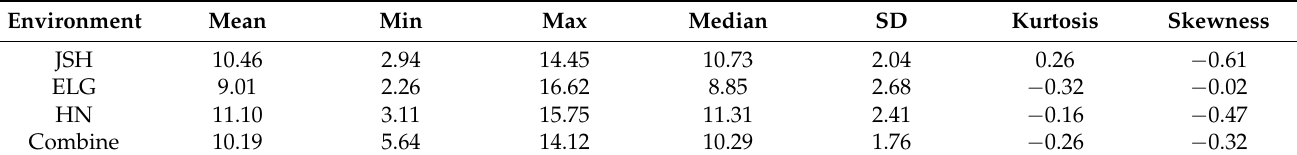
Table 1. Descriptive statistics of maternal haploid inducibility (%) in the F 2 population in three environments.